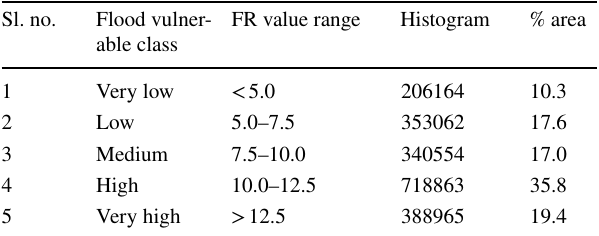
Table 3 Spatial distribution ( statistics) of flood vulnerability classes